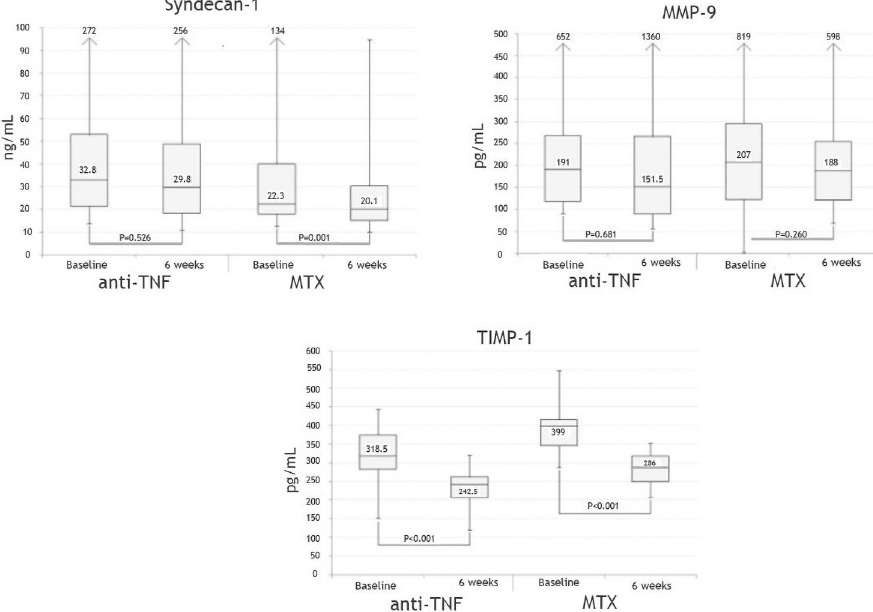
Fig 1. Effect of treatment. Boxplot showing levels of syndecan-1, MMP-9 and TIMP-1 at baseline and after 6 weeks of antirheumatic treatment. Midline represents median. Bottom and top of the box represent 25 and 75 percentile and whiskers represent minimum and maximum values.